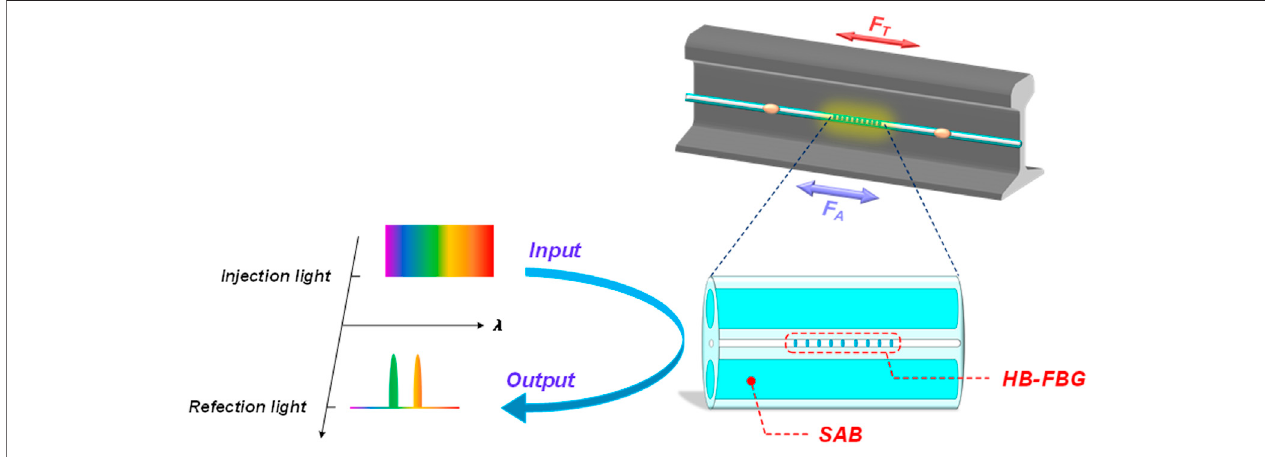
FIGURE 1 | Schematic diagram of HB-FBG based CWR longitudinal rail force measurement. F T : longitudinal temperature force, F A : longitudinal additional force, SAB: stress applying bar, HB-FBG: high-birefringence fi ber Bragg